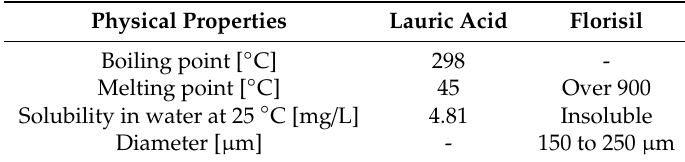
Table 2. Physical properties of the lauric acid and florisil for the experiment.